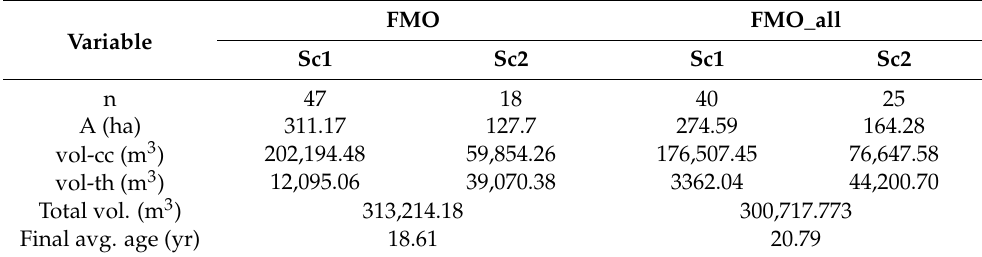
Table 3. Characterization of FMO and FMO_all results according to the optimal solution, discrimi- nated by